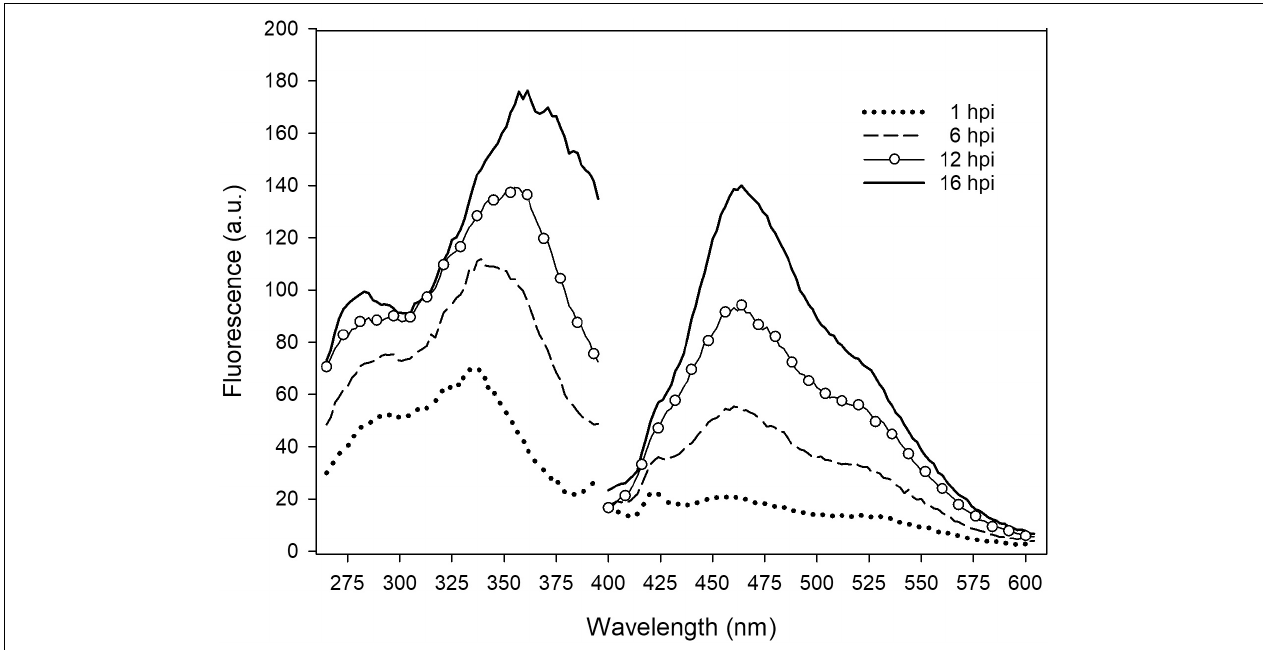
FIGURE 1 | In situ emission and excitation fluorescence spectra of tobacco leaf disk infiltrated with P. syringae pv. tomato DC3000 recorded on the adaxial side at different hpi. The emission spectra were acquired under excitation at 370 nm. The excitation spectra were acquired with emission at 460 nm. Each spectrum is the average of 6 measurements; a.u., arbitrary